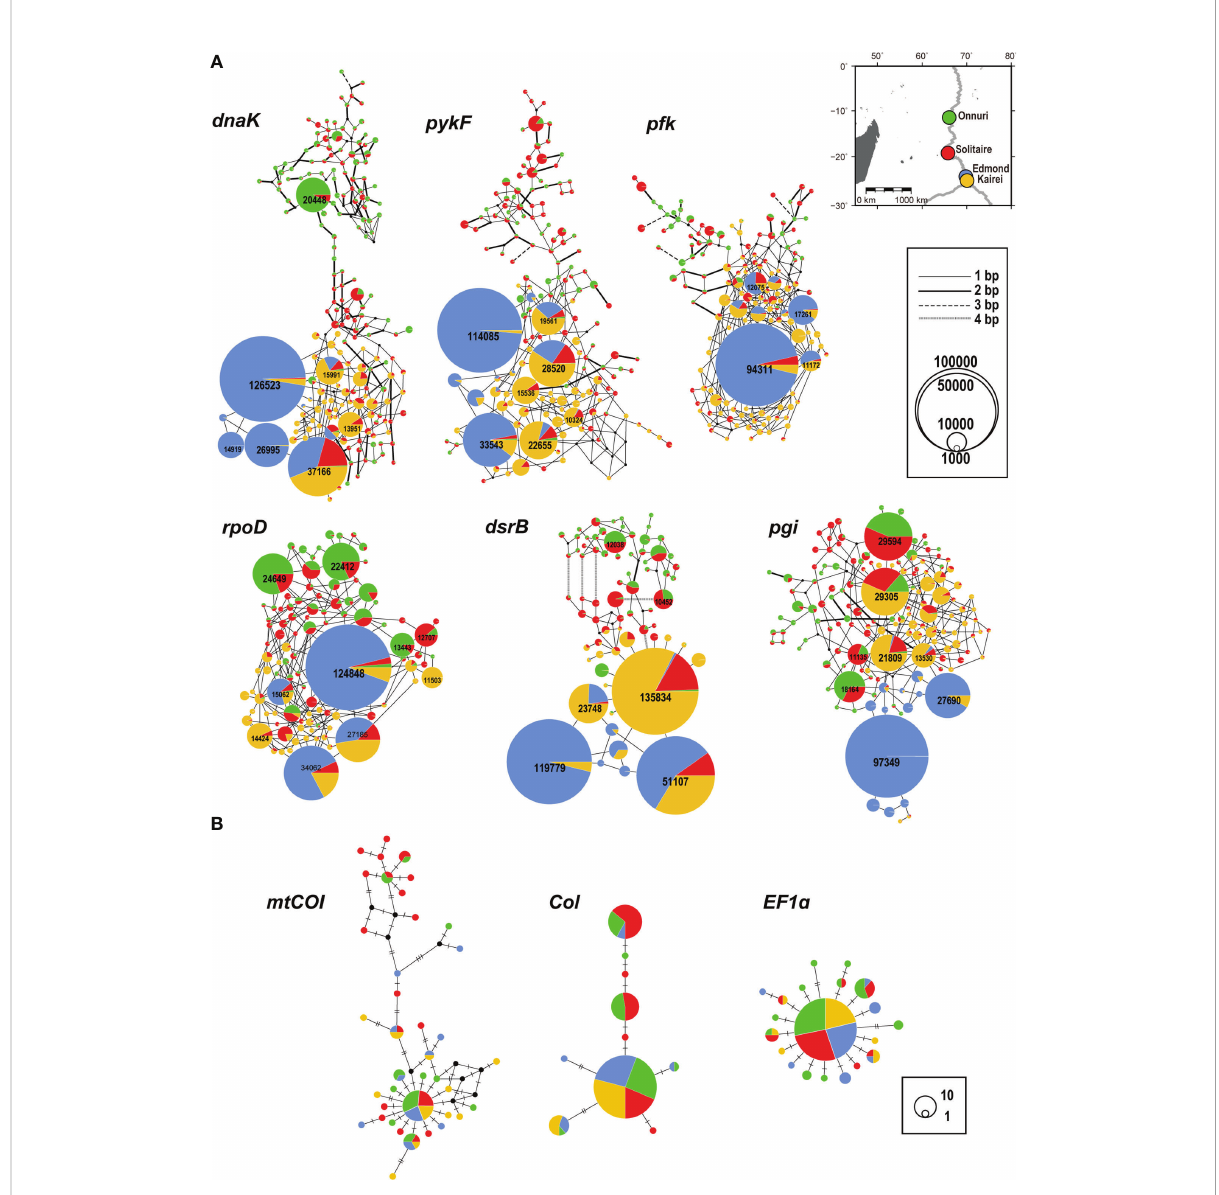
FIGURE 5 Median-joining networks of genes. (A) Symbiotic bacteria. (B) Host mussels. The colors indicate the geographical locality on the map in (A) . The size of the circle represents the abundance of alleles. The black dot represents a hypothetical allele. (A) The network was drawn after eliminating private alleles. The number on the circle denotes the abundance of alleles >10,000. The thickness of the edges represents the number of substitutions between alleles. (B) The number of hatches denotes the number of substitutions between